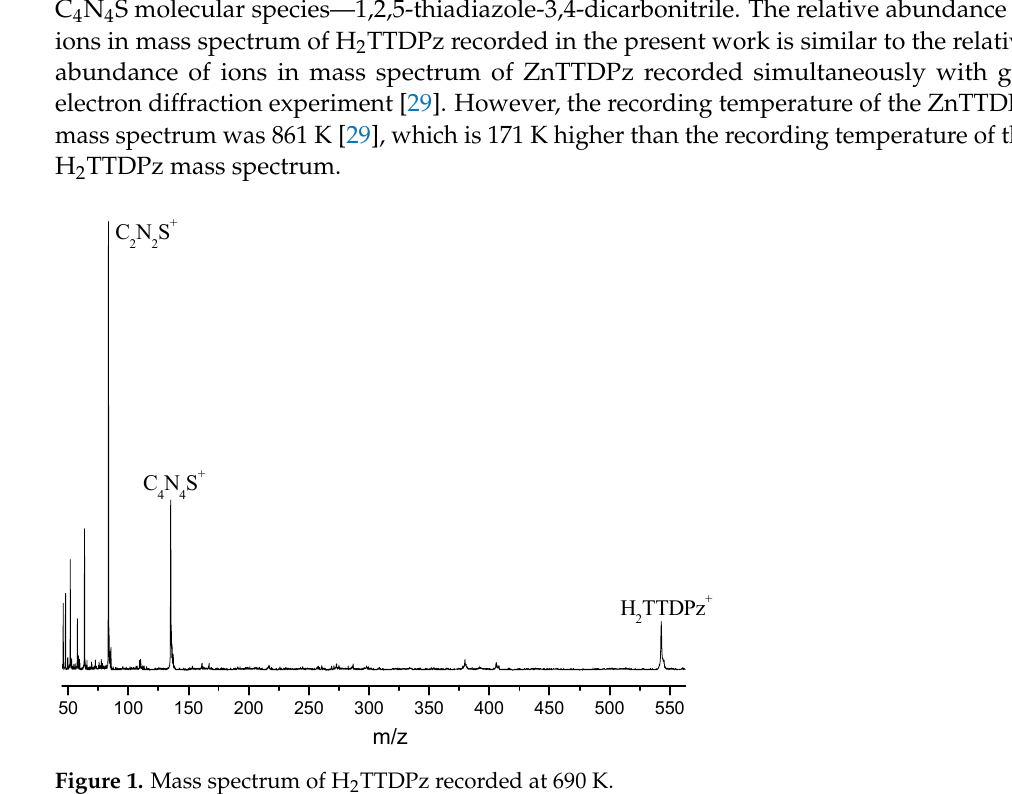
Table 1. Relative abundance of ions from H 2 TTDPz at 690 K.